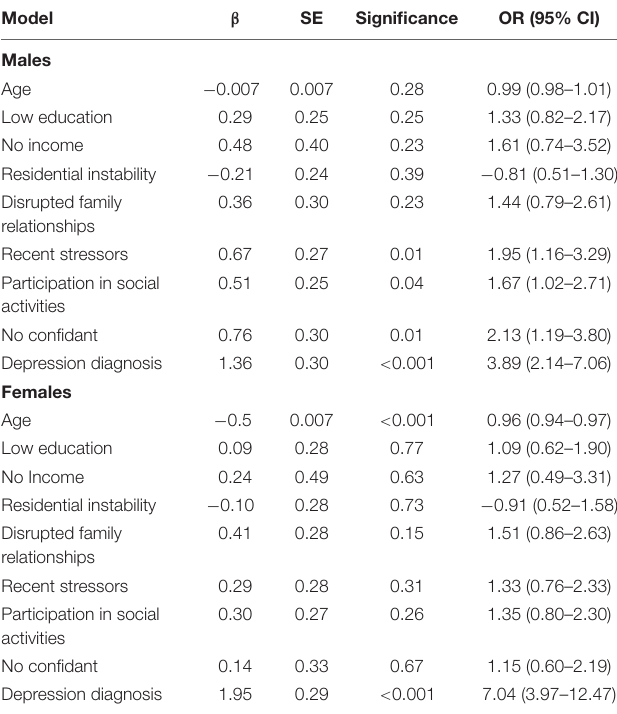
TABLE 3 | Sex-stratified suicide risk models (logistic regressions).